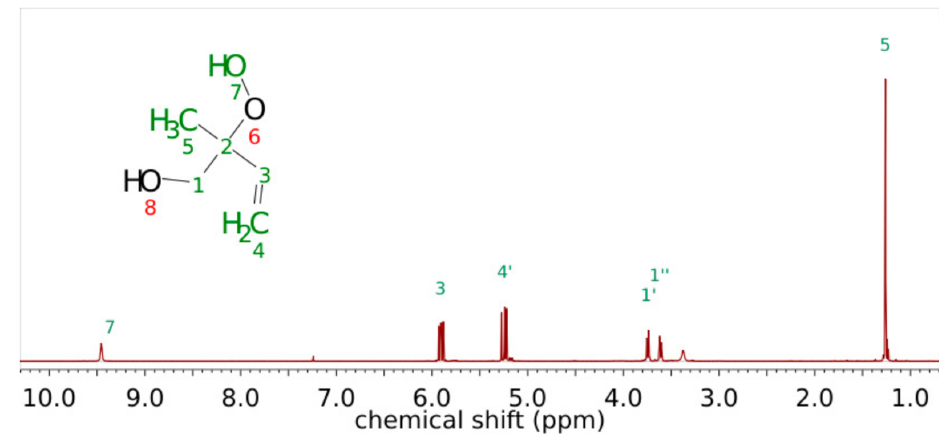
Figure 1. 1 H NMR Spectrum of 1,2-ISOPOOH in CDCl 3 at 600 MHz with peak assignments.